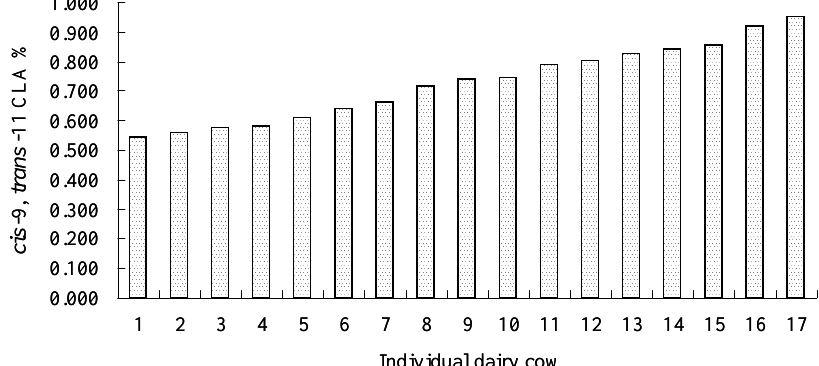
Figure 2. cis- 9, trans- 11 CLA content of milk from individual multiparous dairy cows in the middle lactation stage (Experiment